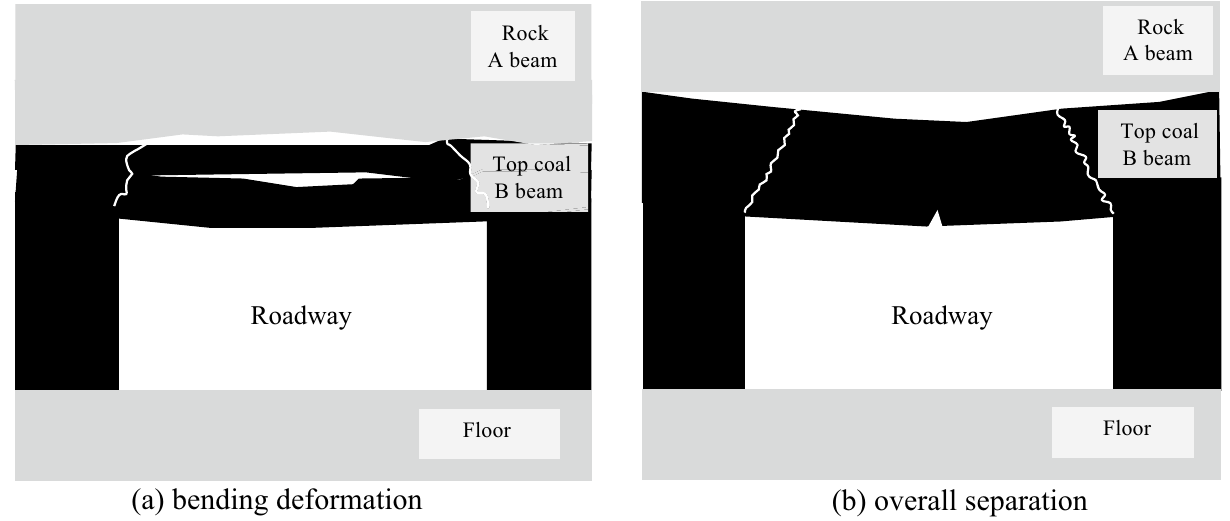
Figure 3. Deformation mode of the roof by top coal roadway in thick